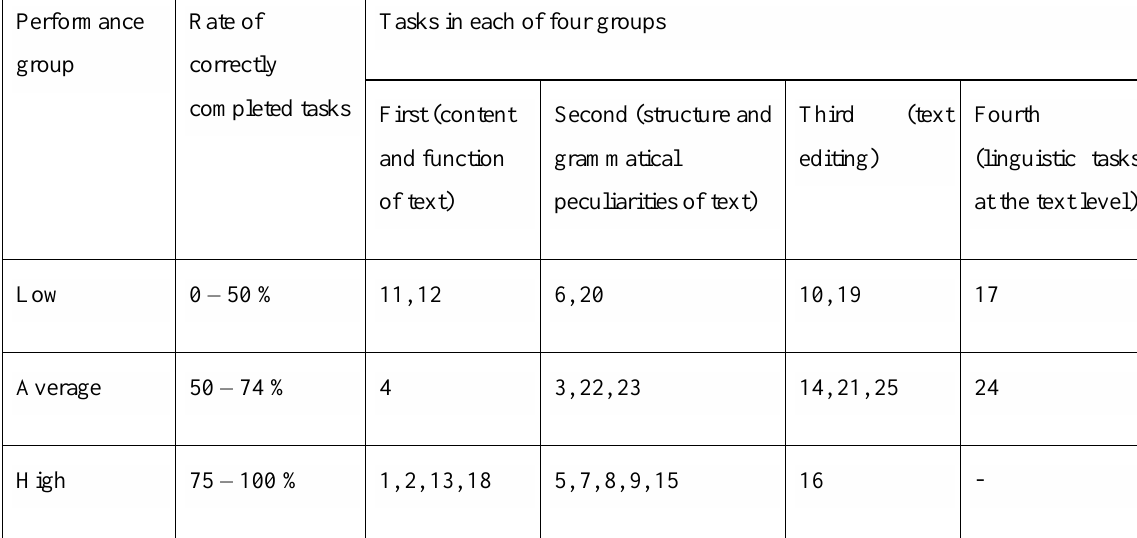
Table 2. The degree of successful completion of text tasks